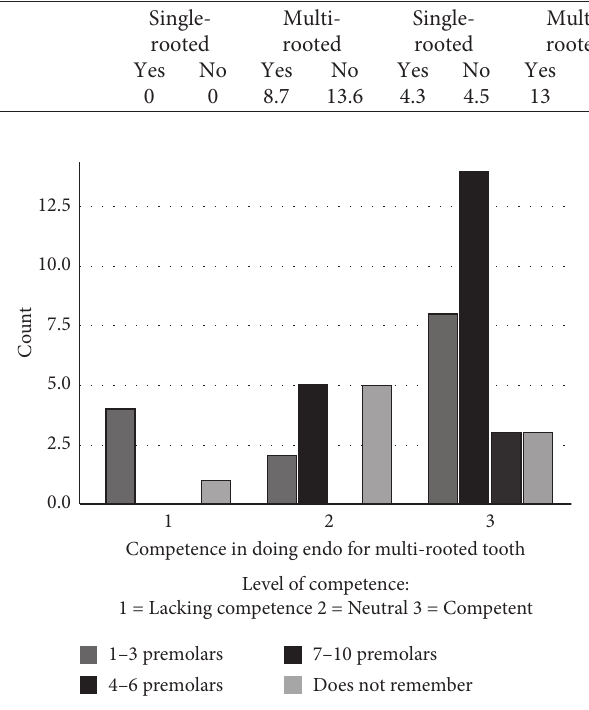
Table 4: Perceived competence in performing root canal treatment according to tooth type and elective course attendance. Perceived competence in root canal treatment